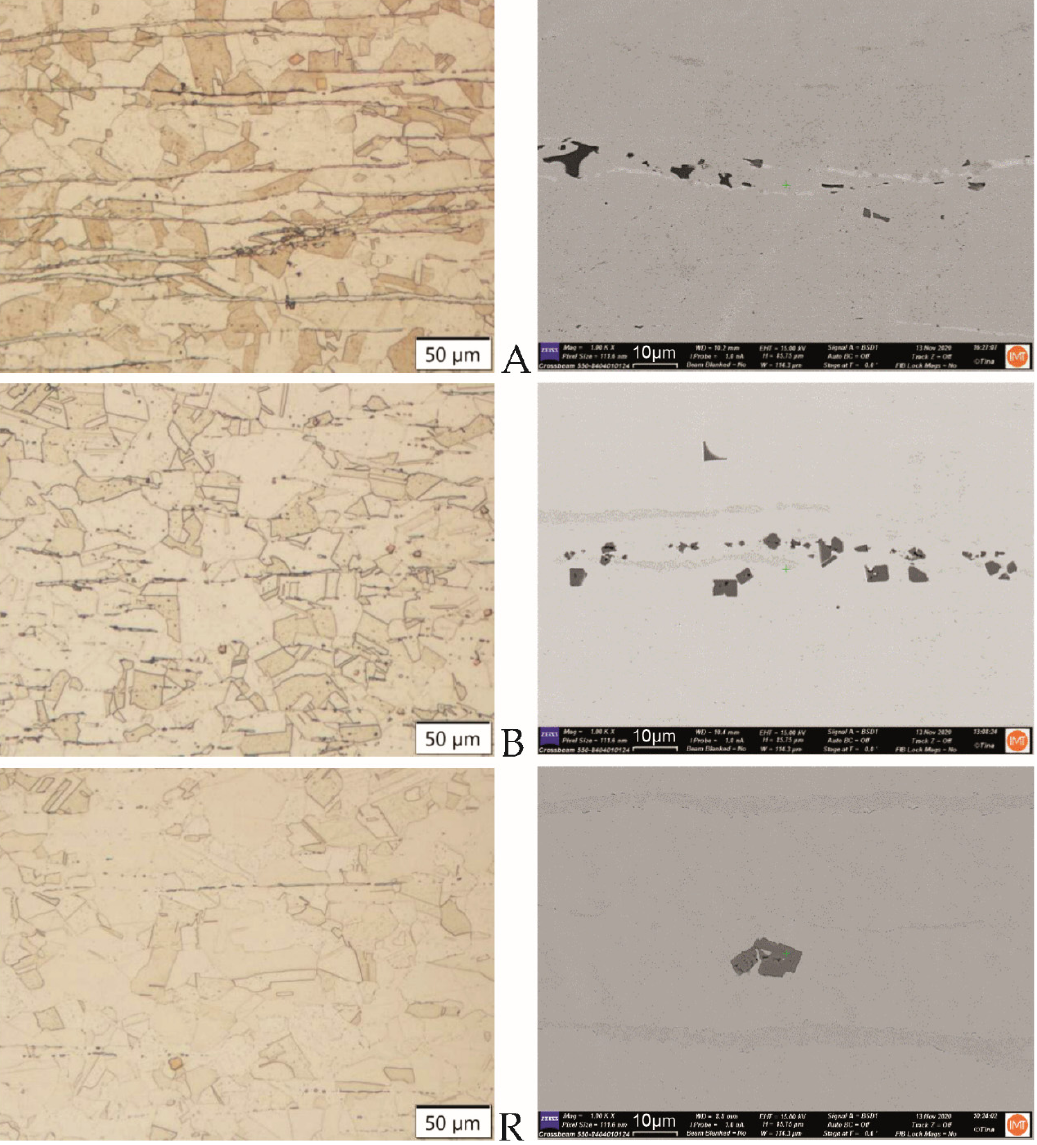
Figure 1. Microstructures of the hot-rolled plates A, B, and R in the rolling direction. ( Left : OM, mag. 200×, etched. Right : FE-SEM-BSI, 1000×, polished).